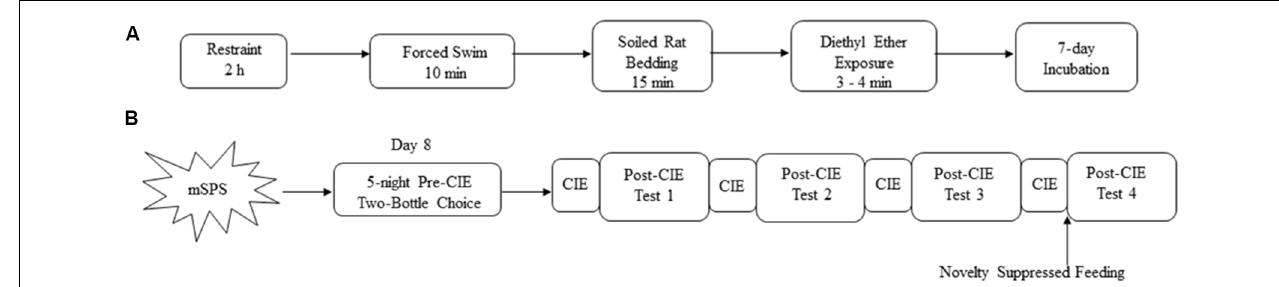
FIGURE 1 | Schematic overview of (A) the mouse single-prolonged stress (mSPS) paradigm, (B) mSPS, and chronic intermittent ethanol (CIE) exposure with two-bottle choice drinking test. After the mSPS paradigm, mice were exposed to two-bottle choice for five nights. Mice were then exposed to CIE exposure every other week, with a Post-CIE drinking test in between the weeks of CIE